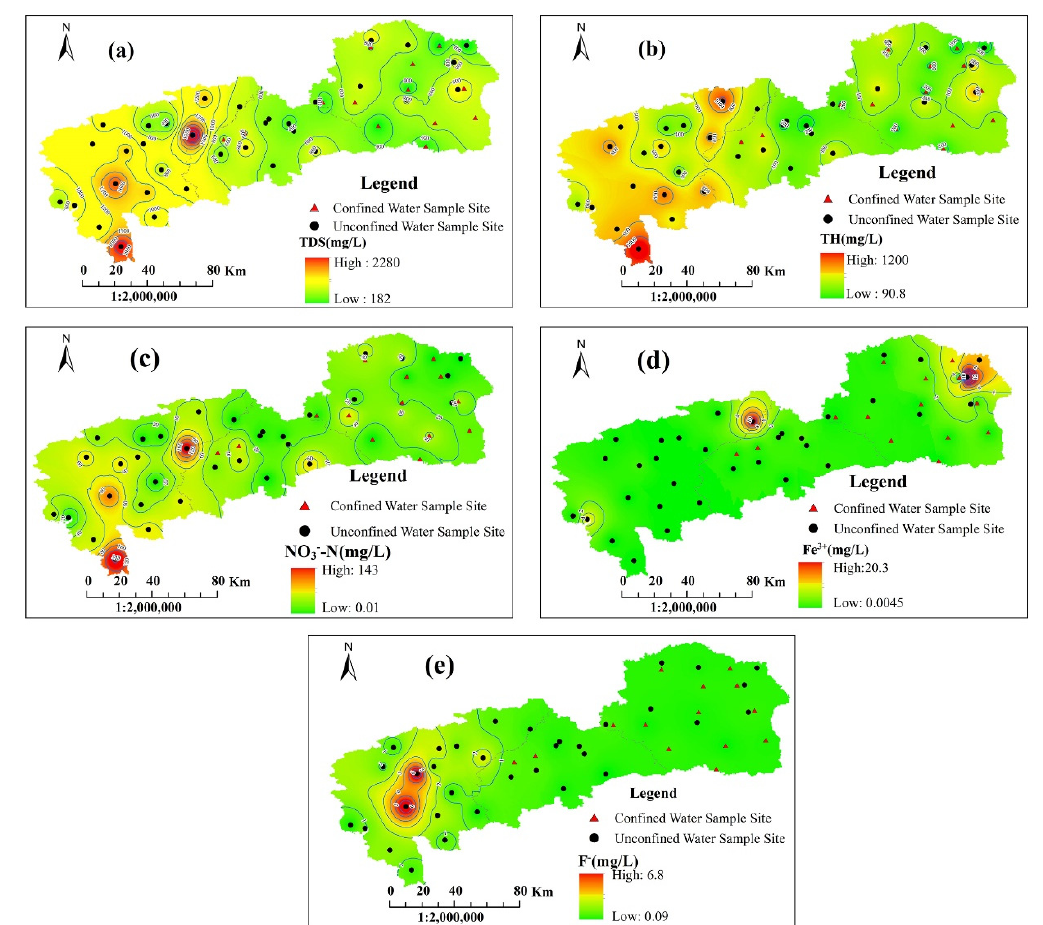
Figure 7. Spatial distribution of five indexes of groundwater in the study area: ( a ) TDS; ( b ) TH; ( c ) NO 3 − -N; ( d ) Fe 3+ ; ( e ) F − .